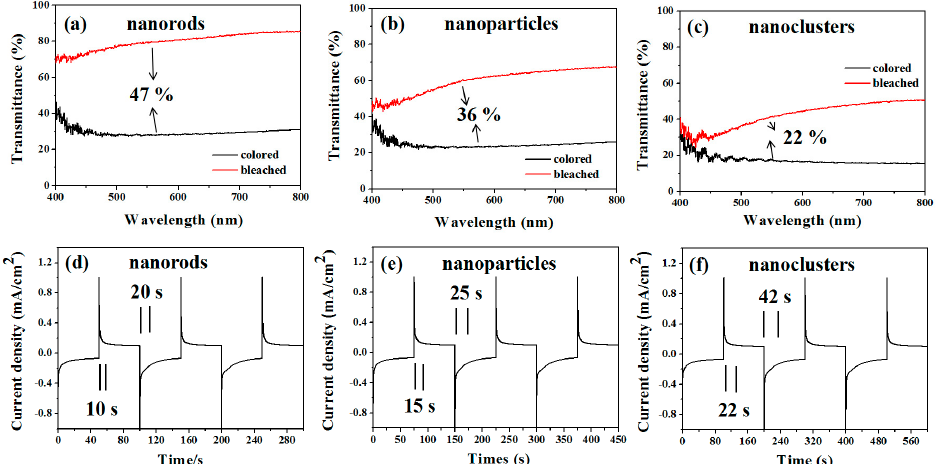
Figure 4. Cyclic voltammograms of MoO 3 nanostructured electrodes at a scanning rate of 50 mV/s. The transmittance changes of ( a ) nanorods, ( b ) nanoparticles, and ( c ) nanoclusters. Response time changes of ( d ) nanorods, ( e ) nanoparticles, and ( f ) nanoclusters.